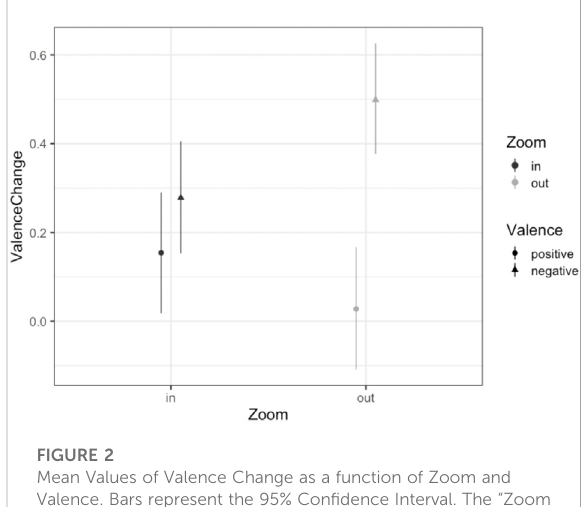
FIGURE 3 Mean Values of Ratings as a function of Time (t1 = pretest, t2 = posttest), Zoom and Valence. Bars represent the 95% Con fi dence Interval. The valence for the negative pictures increased in both the “ Zoom in ” and “ Zoom out ” conditions but increased more in the “ Zoom out ” condition. For the positive pictures, in the “ Zoom in ” condition valence increased at t2 compared to t1, but for “ Zoom out ” it remained about the